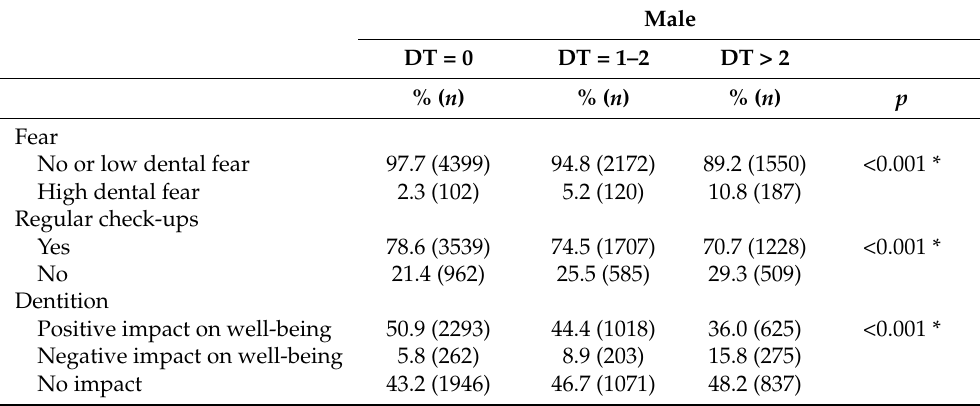
Table 2. Distribution of male participants according to categorised DT values, dental fear, self- reported regularity of check-ups and dentition-related well-being.